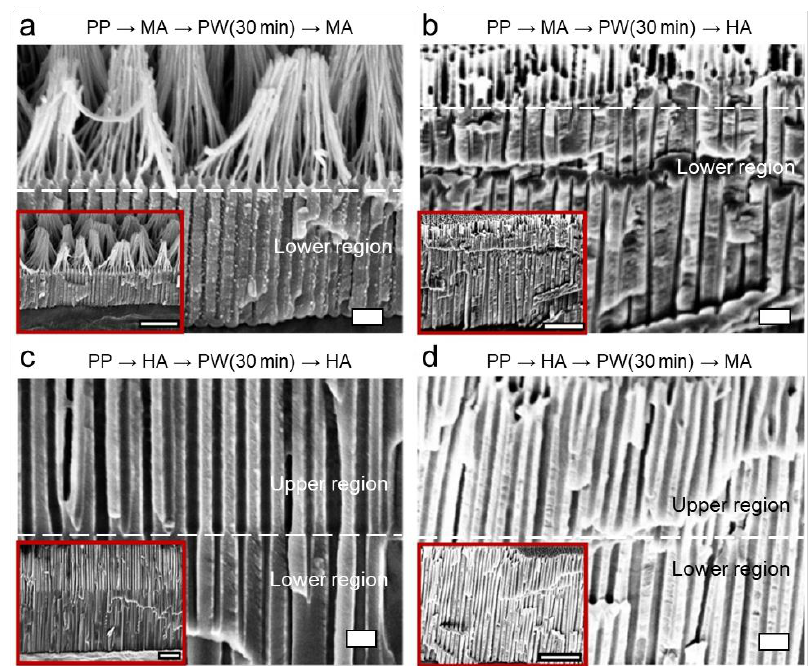
Figure 6. Cross-sectional SEM images of the nanoporous alumina layer formed on the pre-patterned (PP, via MA) aluminum substrate, as a result of the voltage-modulated two-step anodizing process with the intermediate pore-widening (PW) process for 30 min in between. ( a ) PP → MA → PW → MA. ( b ) PP → MA → PW → HA. ( c ) PP → HA → PW → HA. ( d ) PP → HA → PW → MA. The conditions of MA and HA were 40 V for 30 min and 100 V for 0.5 min, respectively. The scale bar in each image represents 200 nm (1 µ m in